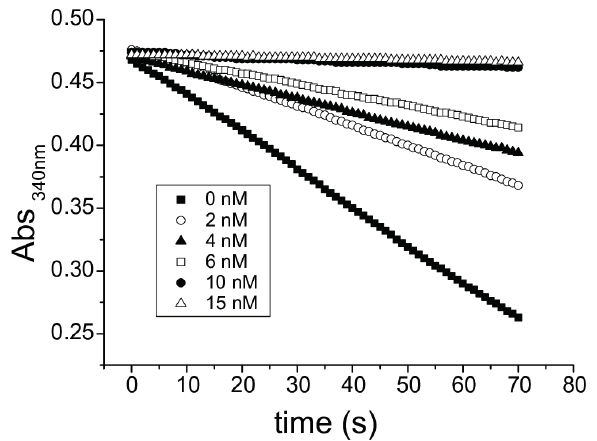
Figure 5. Inhibition of GR activity with Auranofin. Time-courses obtained using different auranofin concentrations are shown. GR assays were carried out at constant concentrations of TGR (2 nM), GSSG (50 µM), NADPH (100 µM) and without GSH. The enzyme was preincubated with the inhibitor during three minutes and the reaction was started by addition of